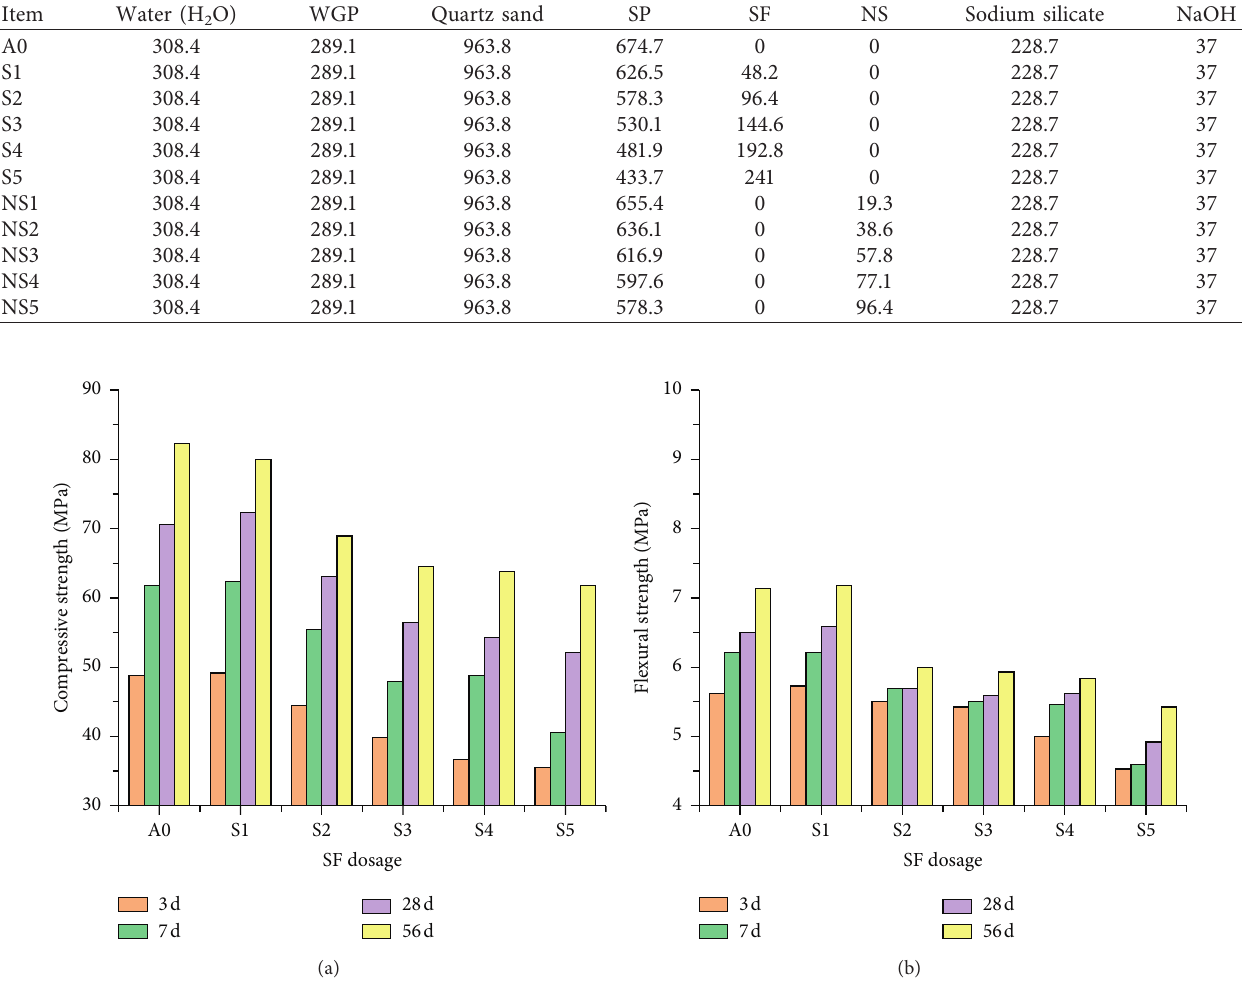
Figure 1: Effects of SF on the AAM compressive strength (a) and flexural strength